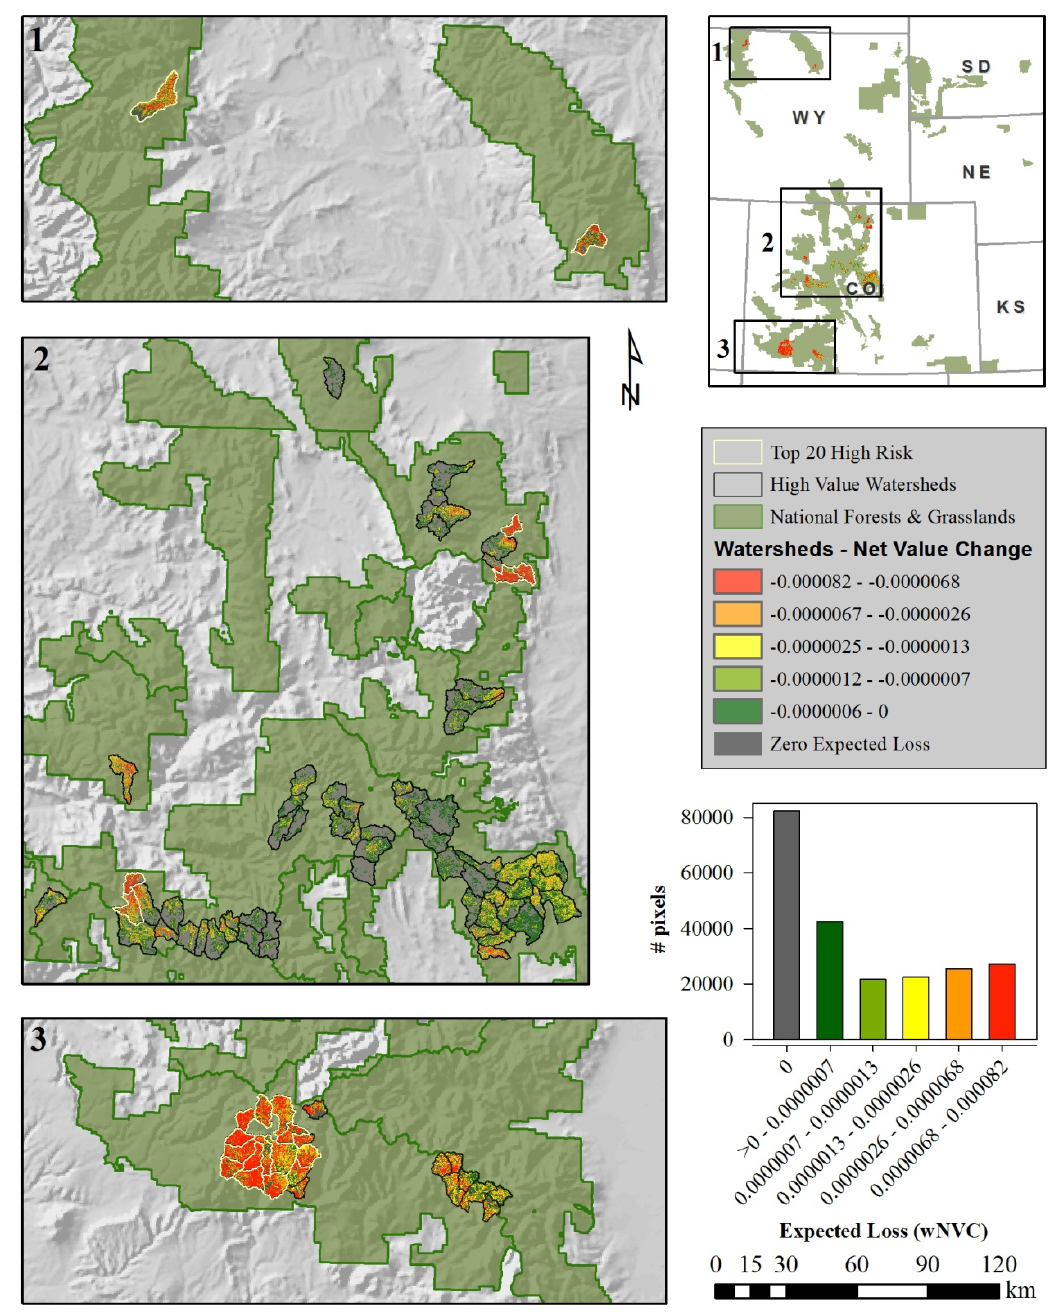
Figure 6. Expected net value change (loss) mapped for the high value watersheds, with the top 20 high risk watersheds identified [See Equation (3)]. CO = Colorado; KS = Kansas; NE = Nebraska; SD = South Dakota; WY =